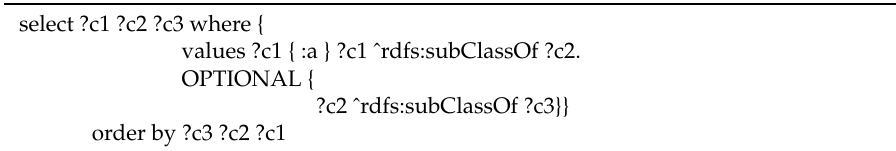
Table 7. SPARQL Query